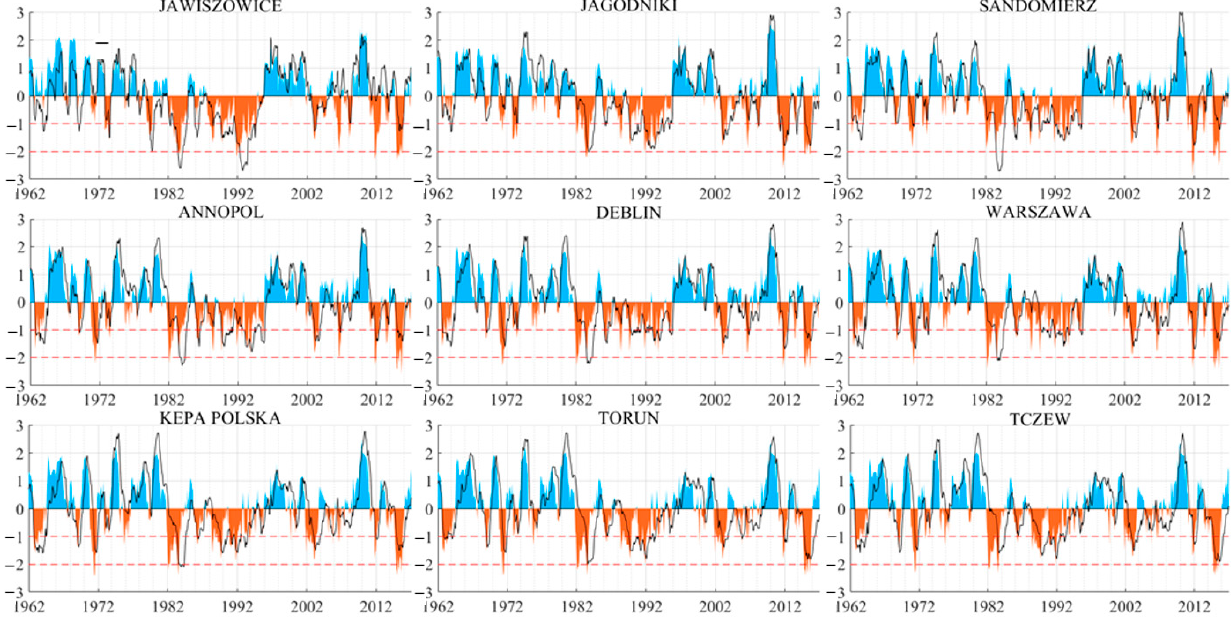
Figure 10. SPEI12 (colored area) and SBFI12 (black line) for the 1961–2017 period for nine sub-basins along the Vistula River.